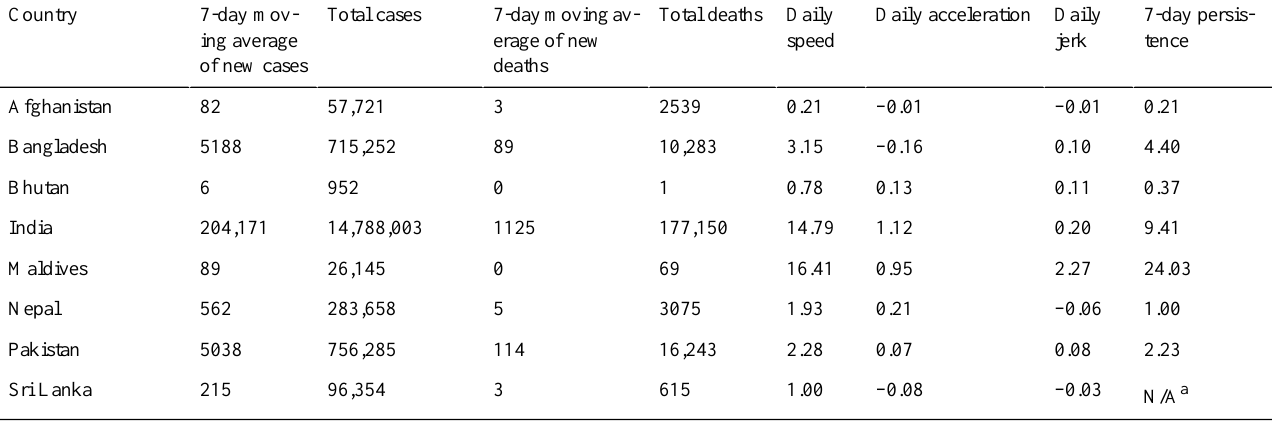
Table 2. Surveillance metrics for the week of April 12-18, 2021.